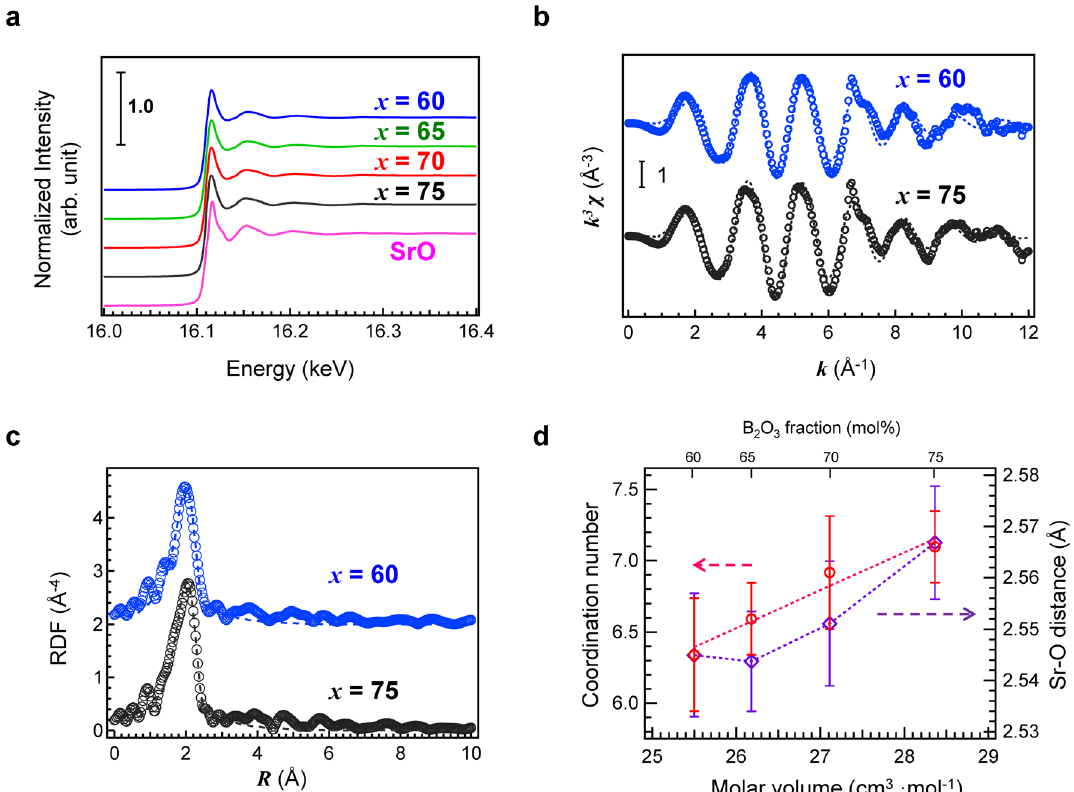
Figure 4. Sr K-edge XAFS analysis of Ce:SBO x glasses. ( a ) Sr K-edge XAFS spectra of Ce:SBO x glasses and SrO reference. ( b ) EXAFS spectra k 3 χ (k) of Ce:SBO60 and Ce:SBO75 glasses and their fitting curves. ( c )